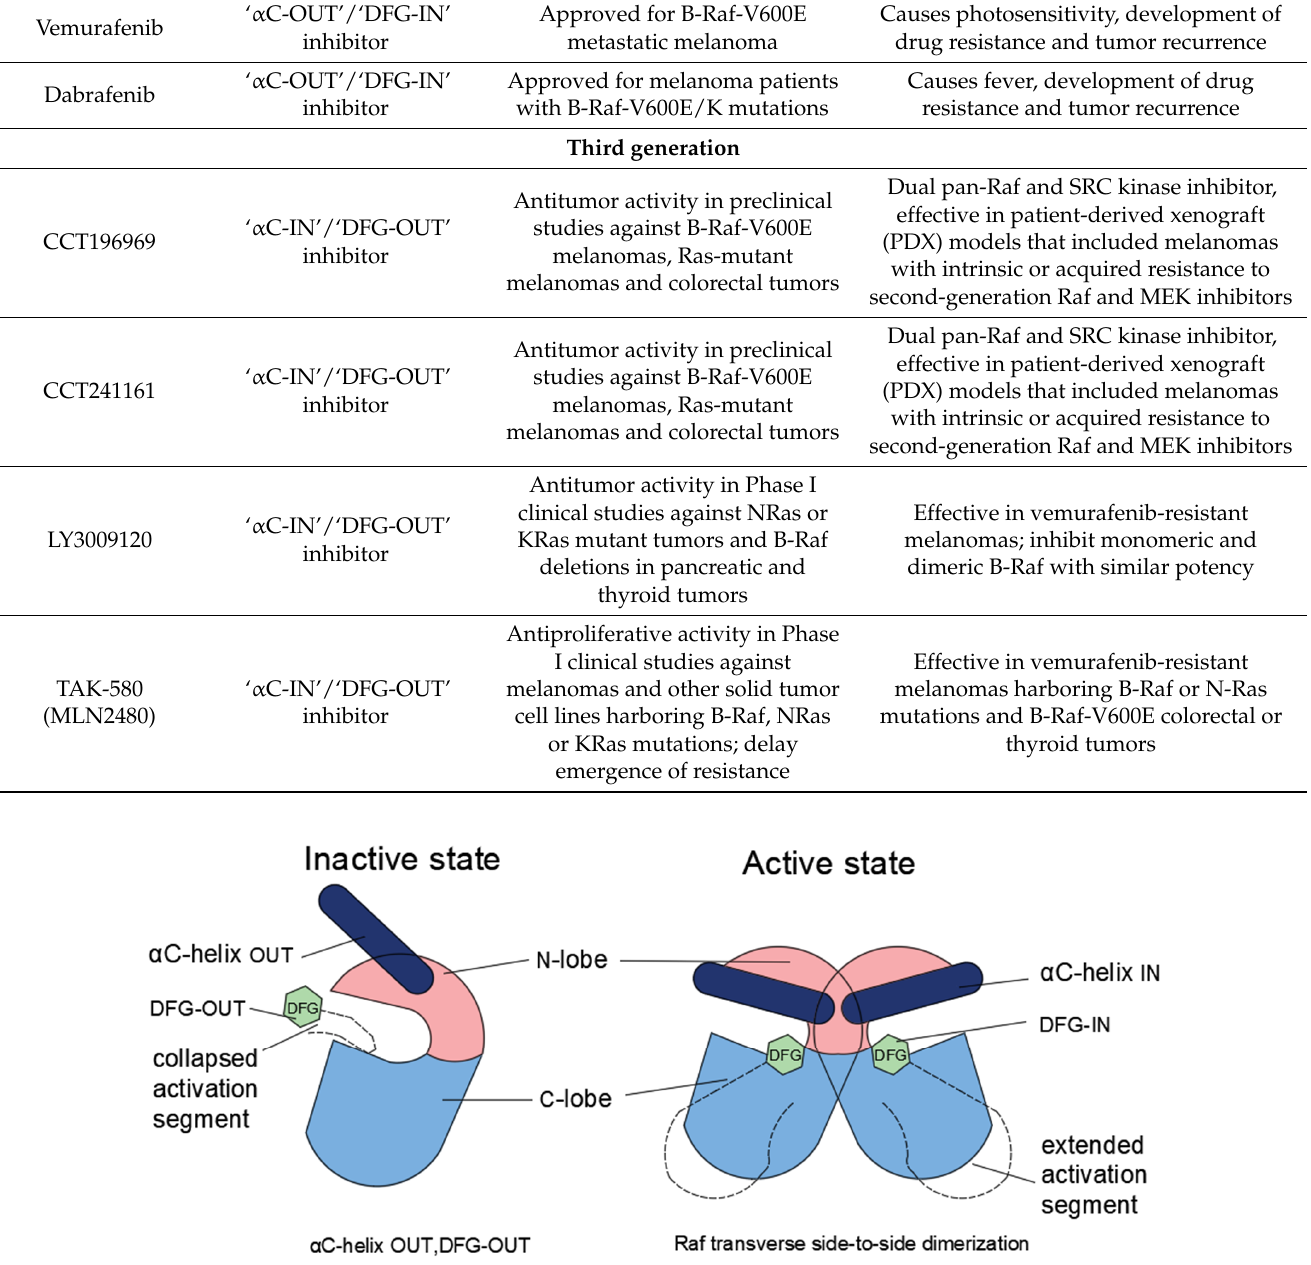
Figure 4. Conformation transition of the Raf kinase domain. The kinase domain consists of an N-terminal lobe (N-lobe) and a C-terminal lobe (C-lobe) linked through a hinge. αC-helix and DFG (green) alter from OUT to IN position upon Raf activation, resulting in a dimer with side-to-side interface “closed” conformation. The conformational transition between inactive and active states is shown.